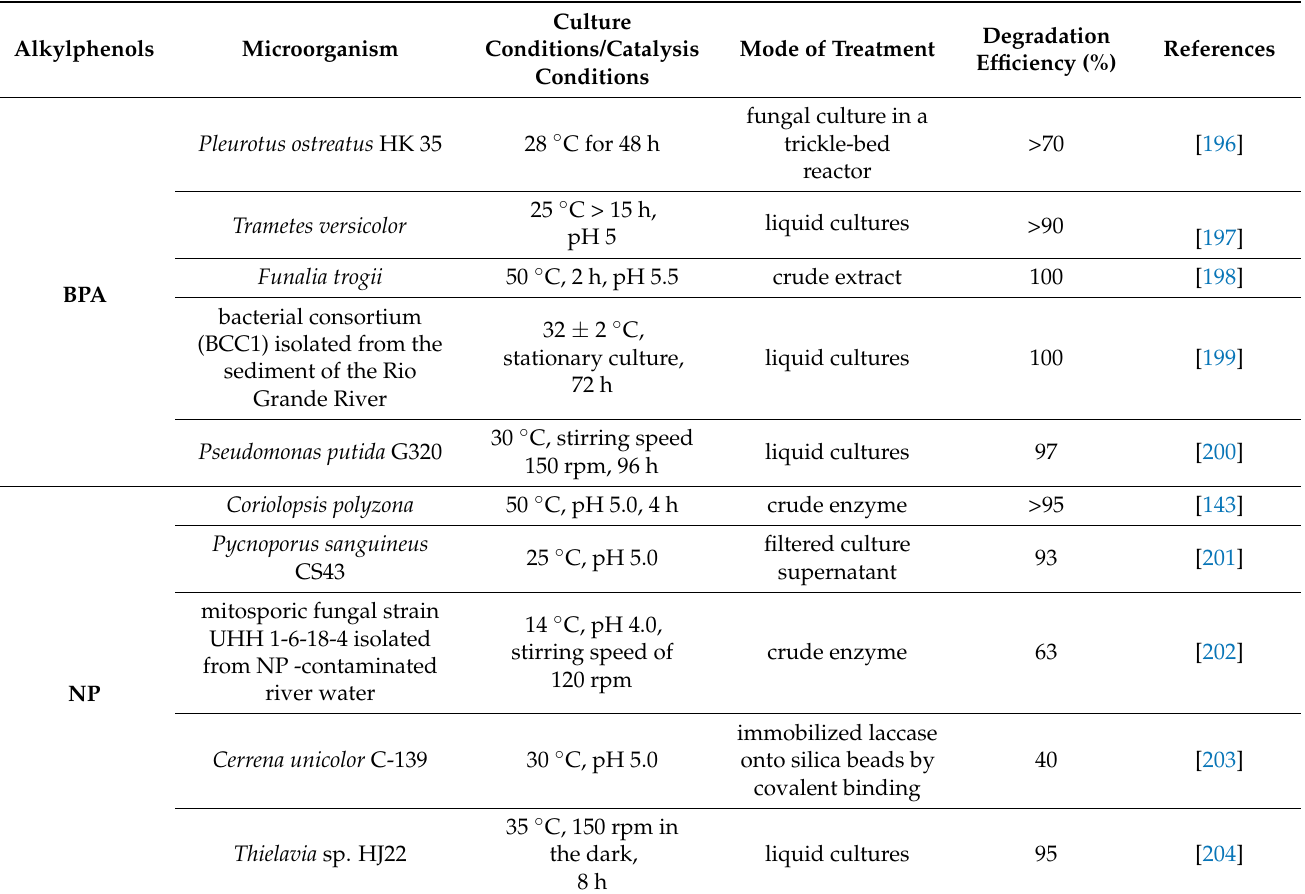
Table 2. Bacterial and Fungal Laccases Degrading NP and BPA